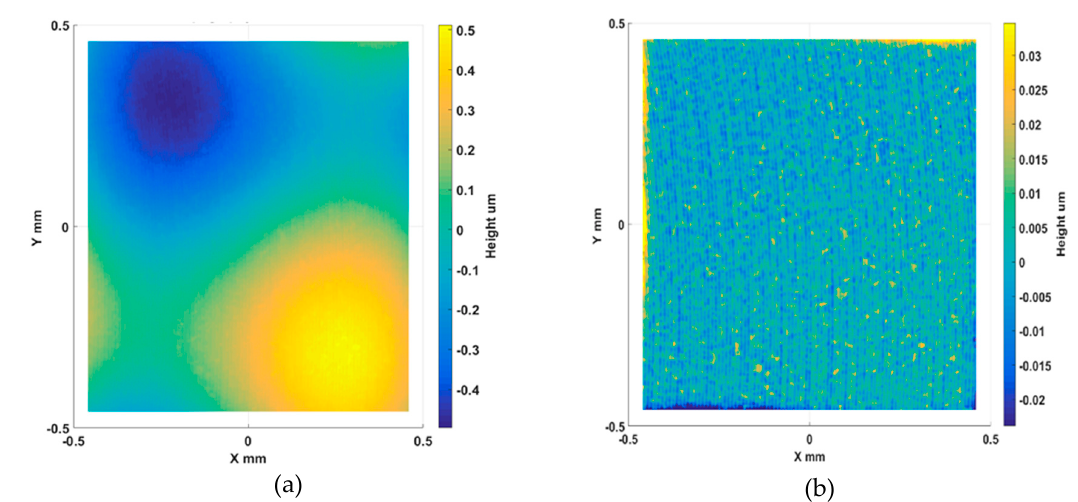
Figure 20. Machined sinusoidal grid surface CCI measurement: original ( a ); after form removal ( b ).